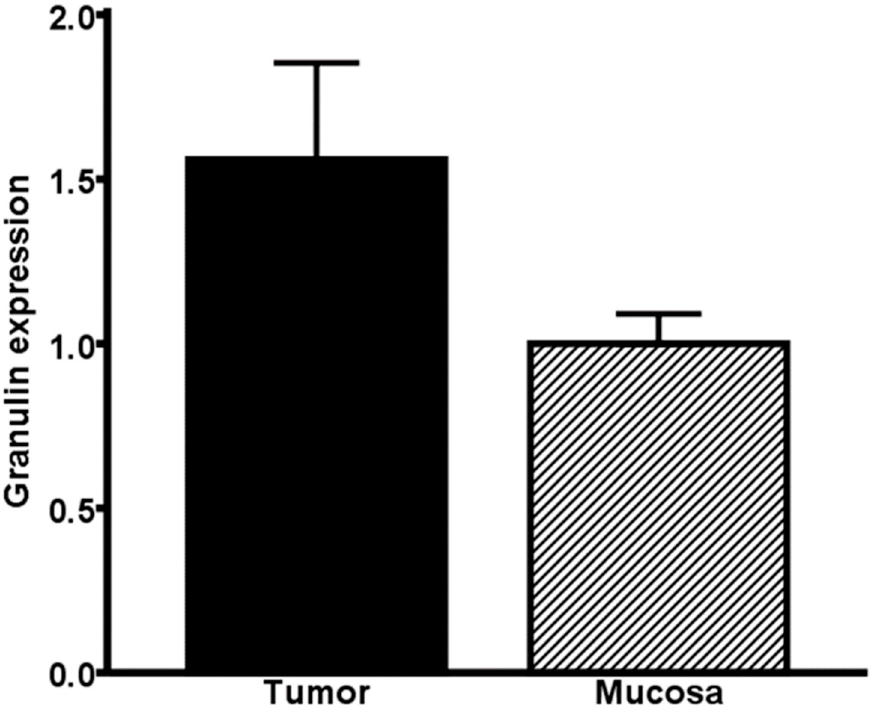
Figure 1. Expression level of granulin. Granulin in tumoral tissue of colorectal cancer specimen and corresponding healthy colon mucosa normalized to 18s rRNA ( n = 94), ( p = 0.059). Bar represents mean + SEM.